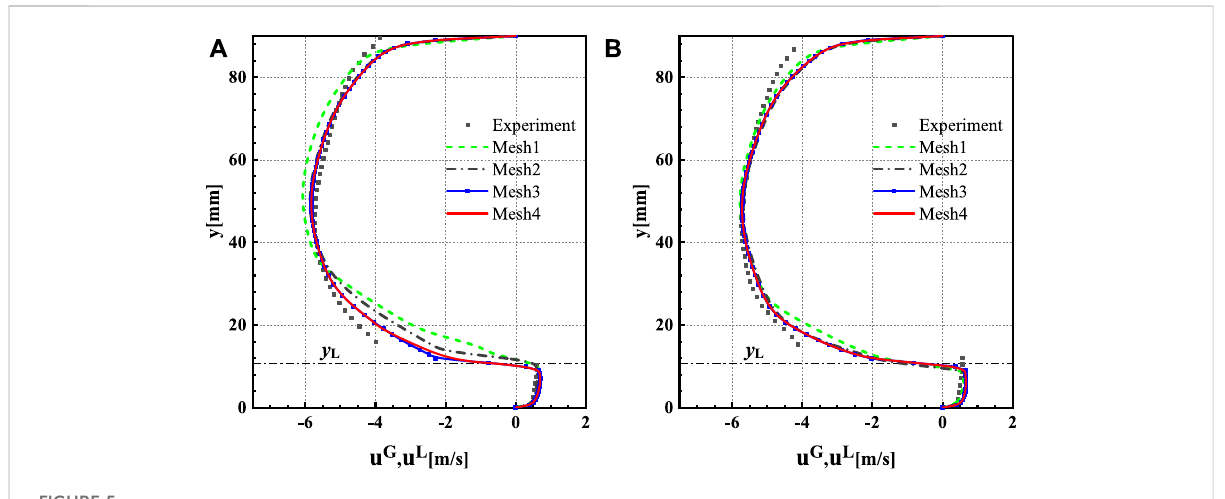
FIGURE 5 Comparison of the x- velocity at MP1 and MP2 for the four meshes, (A) the distribution of the x- velocity at MP1, (B) the distribution of the x- velocity at